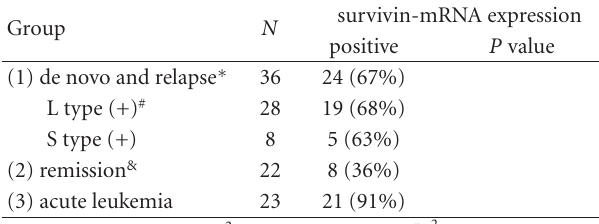
Figure 1: Survivin mRNA expression of NB4 cells treated by ATRA at di ff erent time. Table 1: The results of survivin mRNA expression in de novo, relapse, and remission